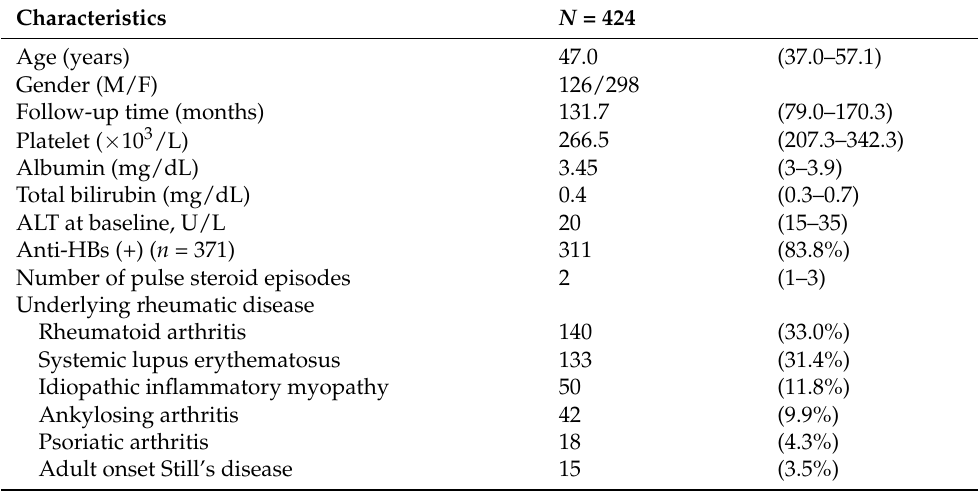
Figure 1. Flowchart of participant recruitments and risk stratification of HBV seroreversion according to concomitant high-risk medications. # prednisolone equivalent dose ≥ 20 mg per day; HBsAg, hepatitis B surface antigen; anti-HBc, antibody to hepatitis B core antigen; HBsAg seroreversion, reappearance of HBsAg from negative to positive; maintained high dose oral steroid, oral prednisolone equivalent over 20 mg/day for over 28 days; anti-HCV, antibody to hepatitis C virus. Table 1. Demographic characteristics of HBsAg-negative and anti-HBc-positive rheumatic patients receiving glucocorticoid pulse therapy.